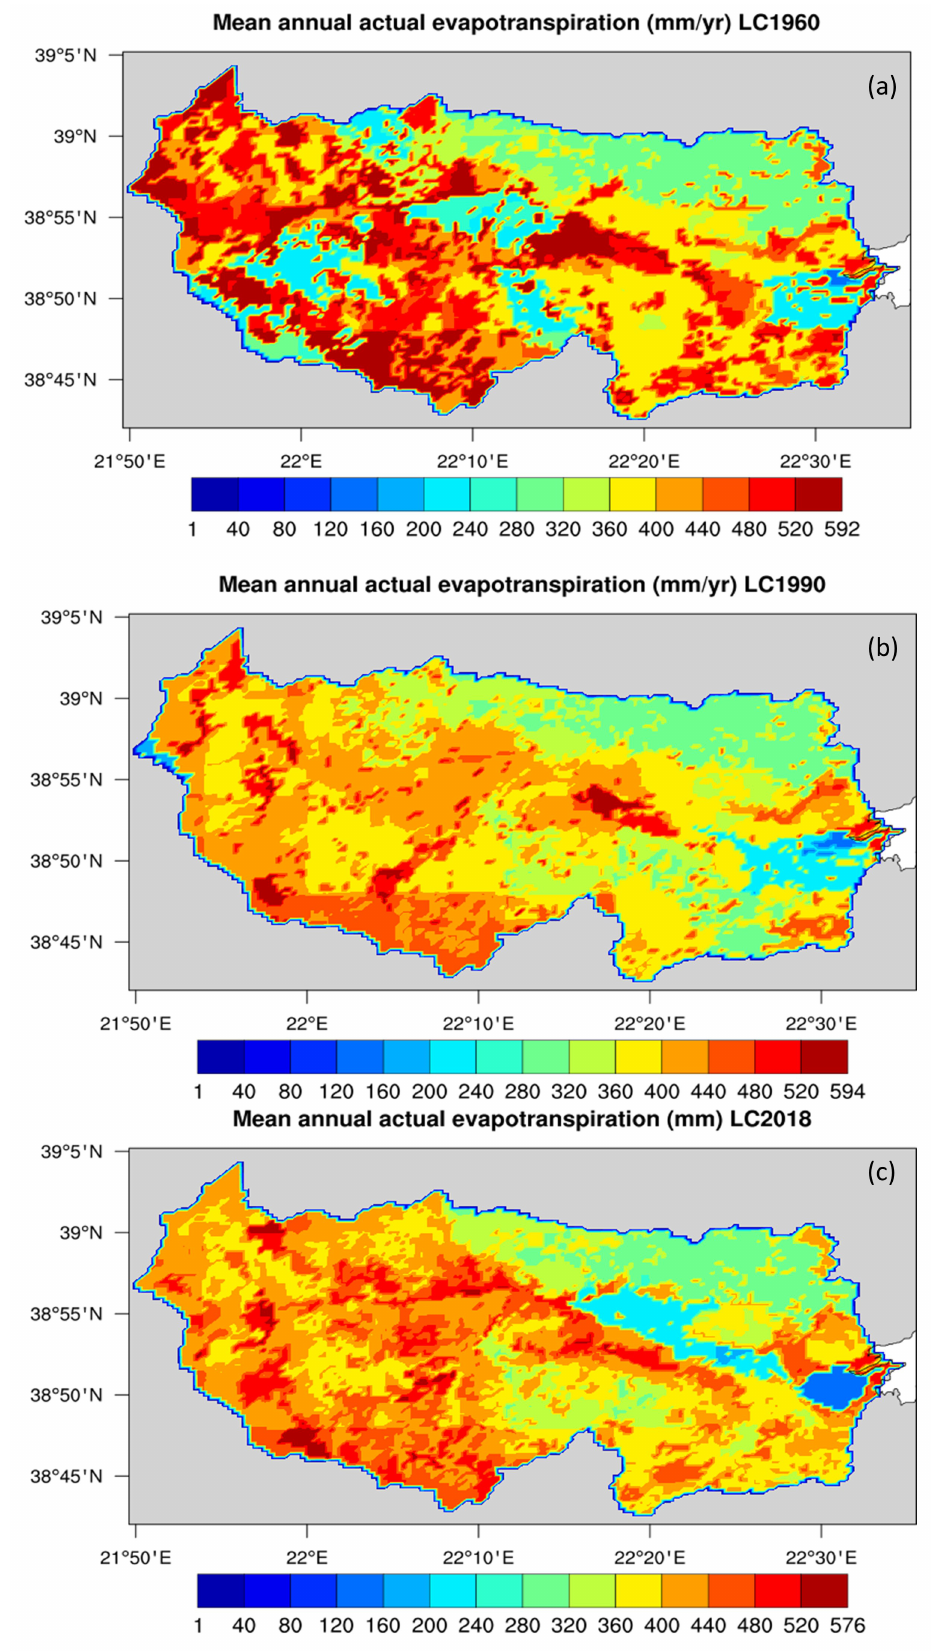
Figure 8. Simulated mean annual actual evapotranspiration (mm / yr) in ( a ) 1960, ( b ) 1990 and ( c )